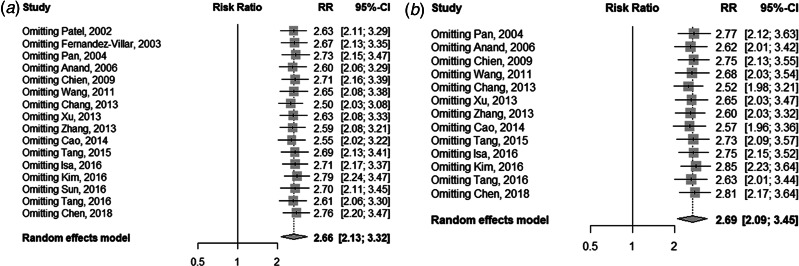
Sensitivity analysis of the association between HBV infection and the risk of anti-TB DILI. (a) For all including studies; (b) excluding the fair-quality studies.